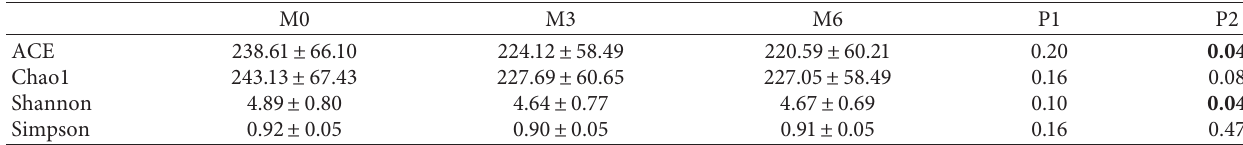
Table 2: Alpha-diversity before and after inulin supplementation.